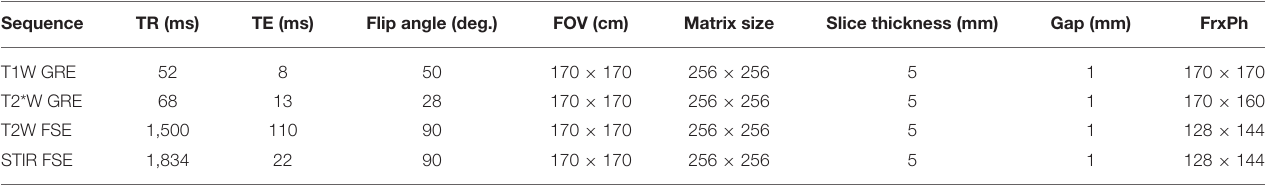
TABLE 1 | Standing low-field MRI parameters used during tendon sheath examination in this study. Sequence